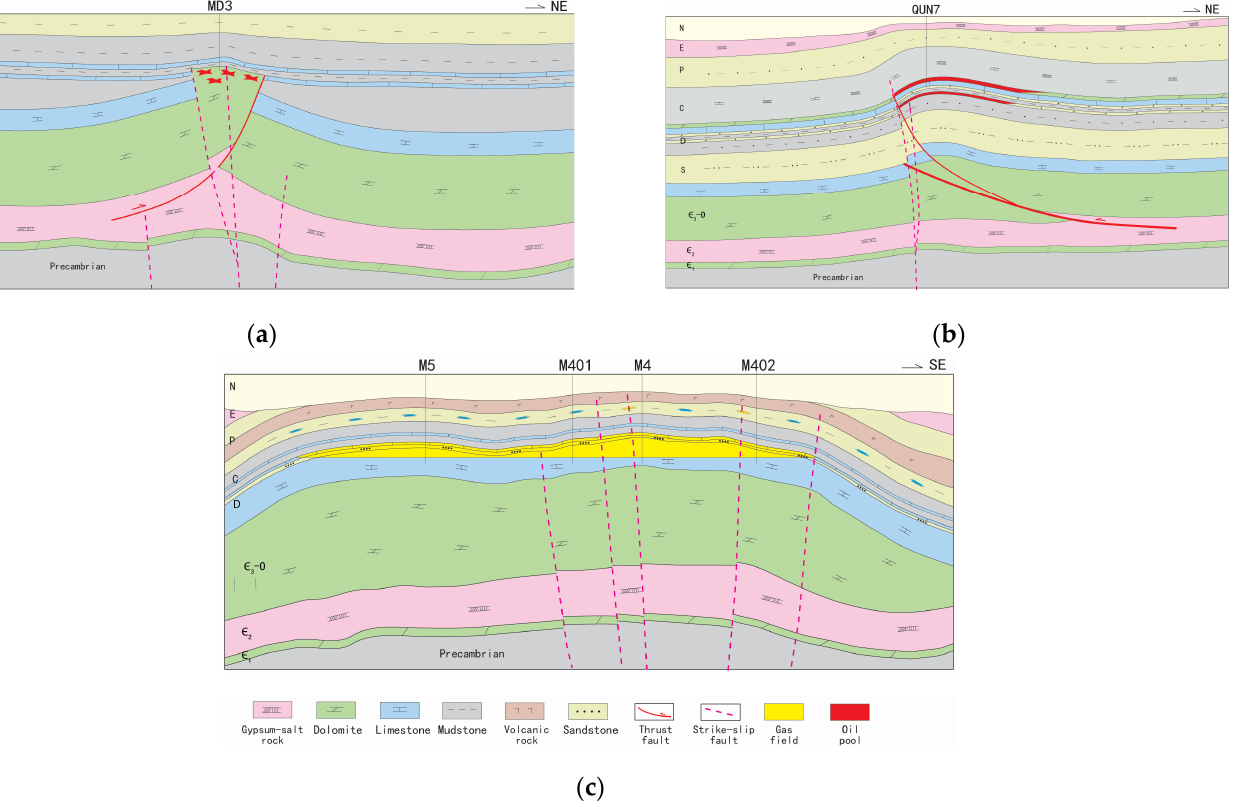
Figure 8. Control of hydrocarbon accumulation about strike-slip fault in different periods, Maigaiti Slope. ( a ) Reservoir profile of Madong 3 oil pool—late Caledonian. ( b ) Reservoir profile of Bashituopu oil pool—late Hercynian. ( c ) Reservoir profile of Hetianhe gas field—late Hercynian.